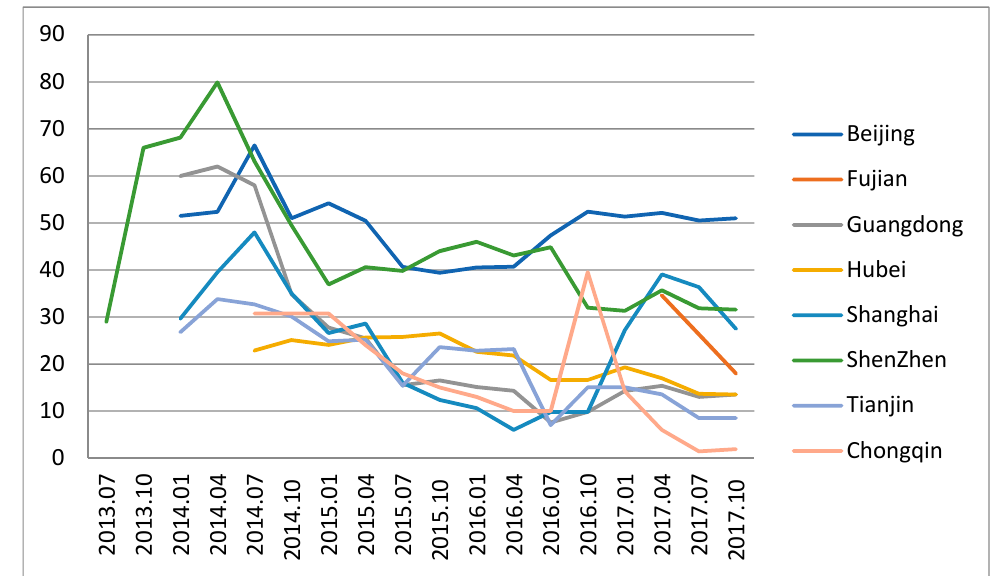
Figure 1. Quota price in first trading day of each quarter during 2013 to 2017 in Chinese ETS pilots [55].